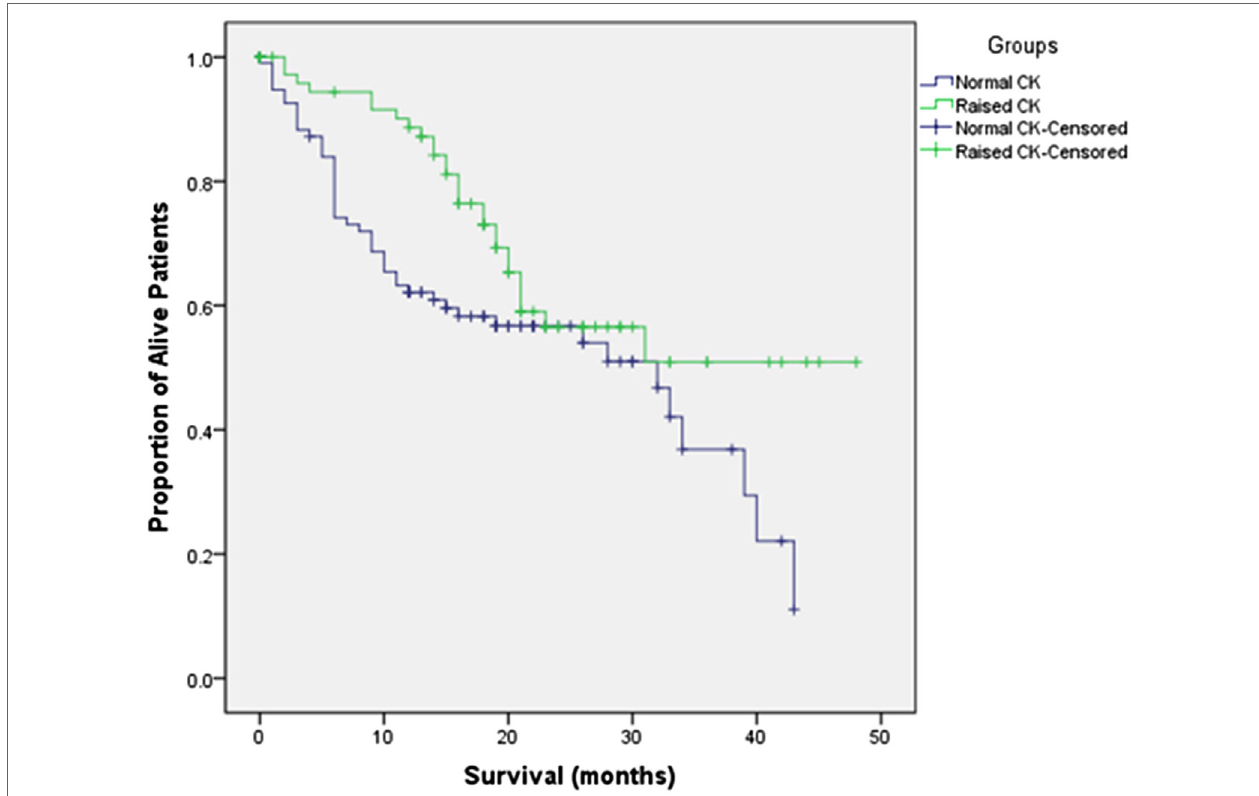
FigUre 1 | Kaplan–Meier survival curves for amyotrophic lateral sclerosis patients with normal creatine kinase (CK) versus raised CK